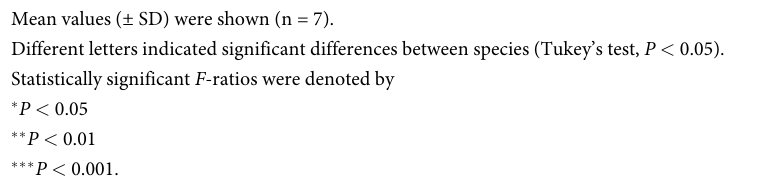
Mean values ( ± SD) were shown (n =